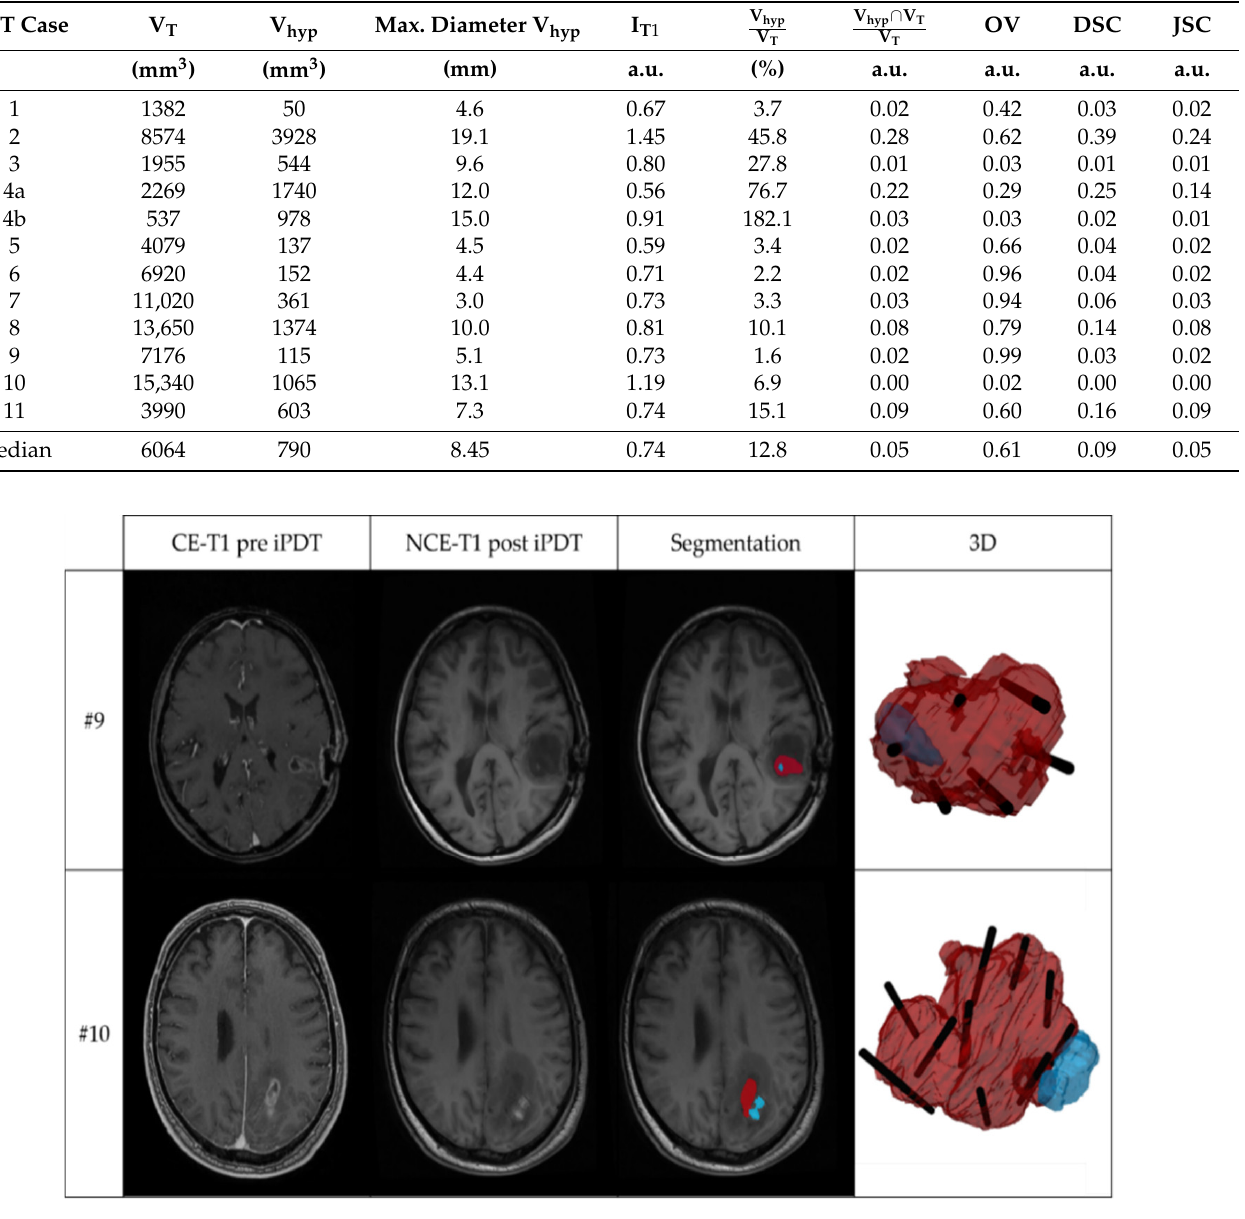
Figure 3. Two examples of MRI and 3D superimposition visualization, showing: contrast-enhanced T1-weighted MRI before iPDT (CE-T1 pre iPDT); non-contrast-enhanced T1-weighted MRI after iPDT (NCE-T1 post iPDT); segmentation of the tumor volume (red) and intrinsic T1 hyperintensity (blue) based on the CE-T1 pre iPDT and NCE-T1 post iPDT images; and 3D superimposition of tumor volume (red), intrinsic T1-hyperintensity volume (blue), and planned localization of irradiating tips of cylindrical diffuser fibers (black). The upper panel shows iPDT case #9 with the largest overlap coefficient (OV = 0.99); the lower panel iPDT case #10 with smallest overlap coefficient (OV = 0.02). In total, 5/11 patients had an OV < 0.5, but the volume of intrinsic T1 hyperintensity Table 2. Tumor volume (V T ) and properties of the intrinsic T1 hyperintensity volume (V hyp ) of the was still located in close proximity to the contrast-enhancing tumor region. DSC and JSC different iPDT cases and the calculated Overlap (OV), Dice (DSC), and Jaccard (JSC). show the positional agreement between tumor and T1 hyperintensity to be 0.39 or 0.24 at most, respectively (median: 0.09/0.05). A higher OV than DSC or JSC further indicates the high volume differences between V T and V hyp. Further comparison of the